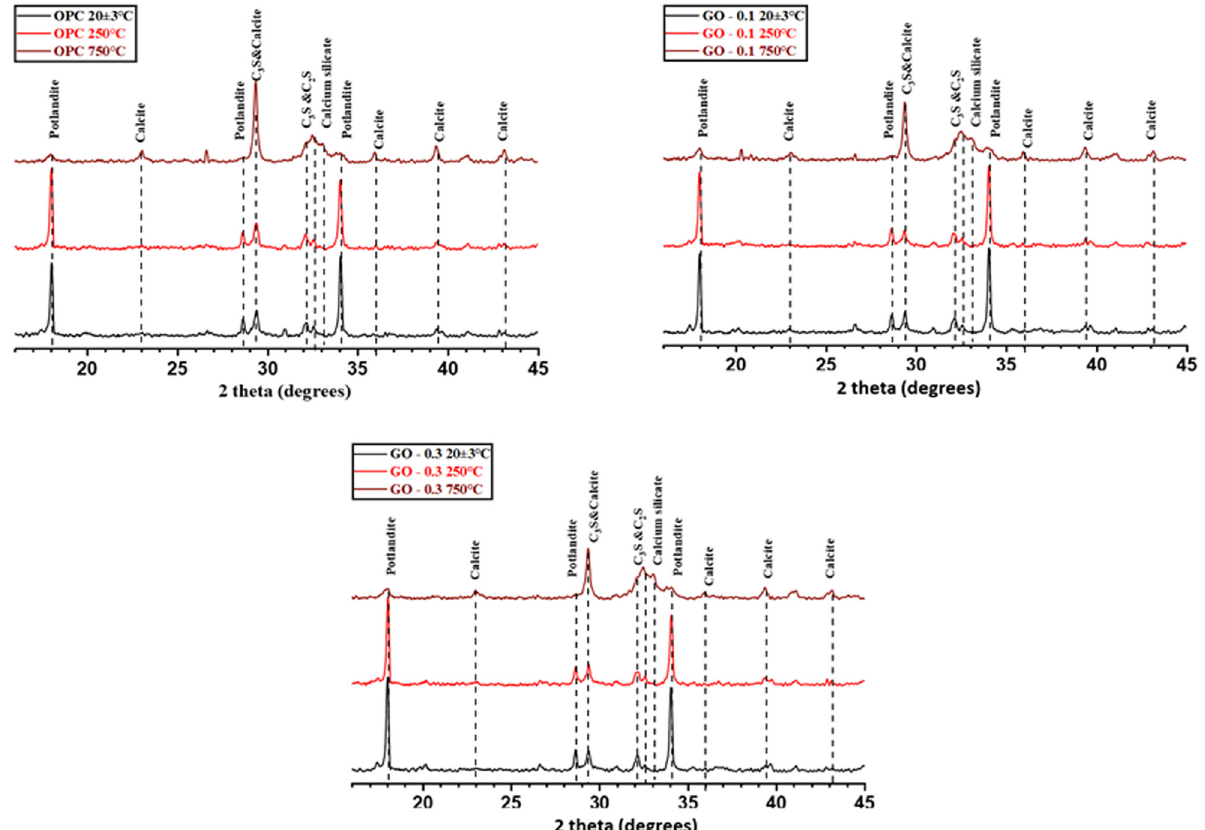
Figure 11: XRD patterns after thermal